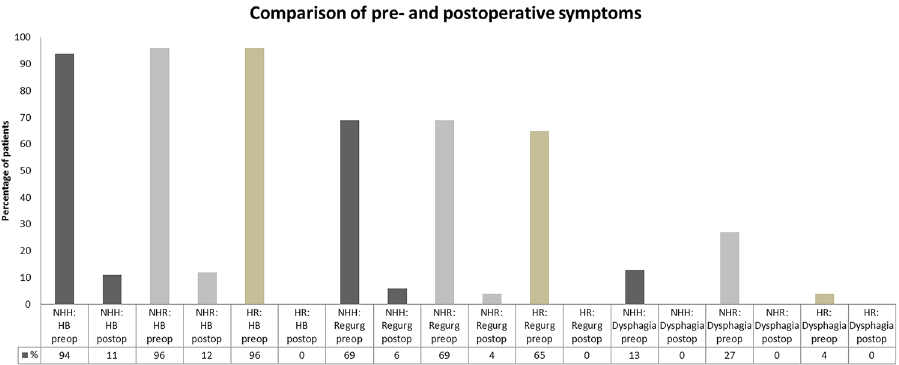
Figure 2. Comparison of pre- and postoperative symptoms (%) between groups (NHH, NHR and HR groups).